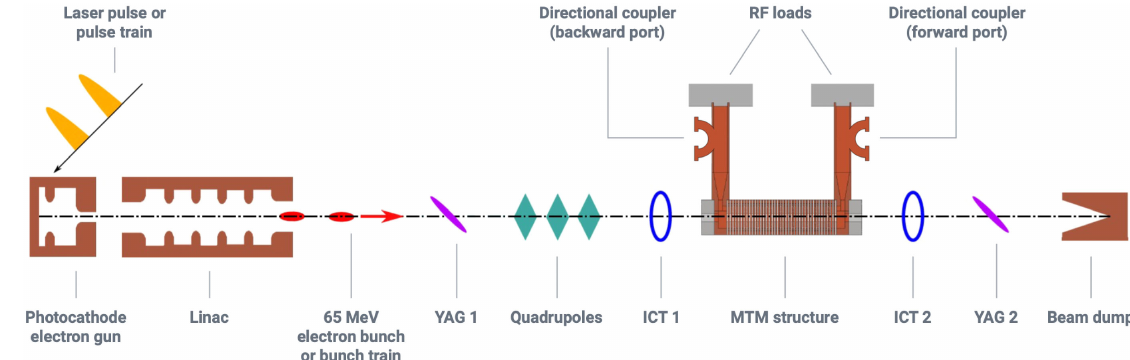
FIG. 14. A simplified model of the AWA beamline setup during the Stage III experimental run. Bunch trains were monitored using YAG screens before and after the structure and charge was measured with ICTs. Dipole trim (not shown) and quadrupole magnets allow for steering. Figure modified from [46].